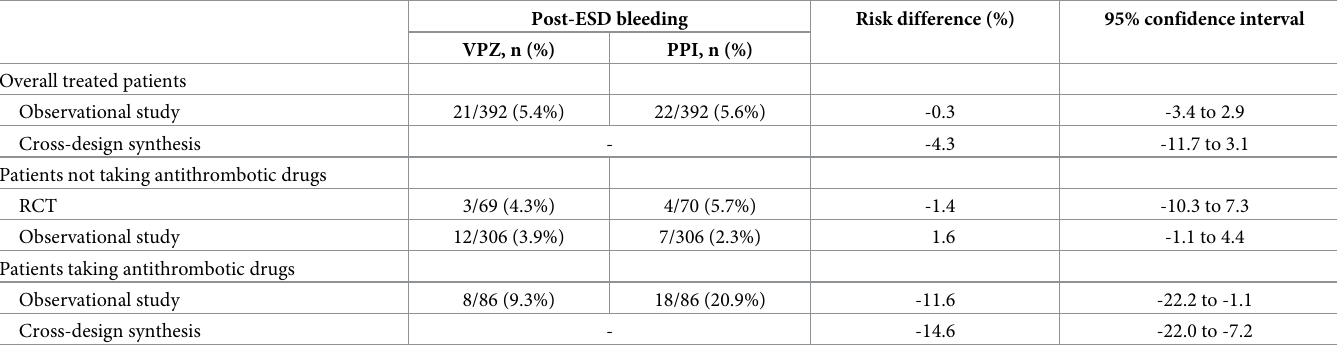
Table 4. Efficacy of vonoprazan compared with proton pump inhibitors in preventing post-ESD bleeding according to antithrombotic drug